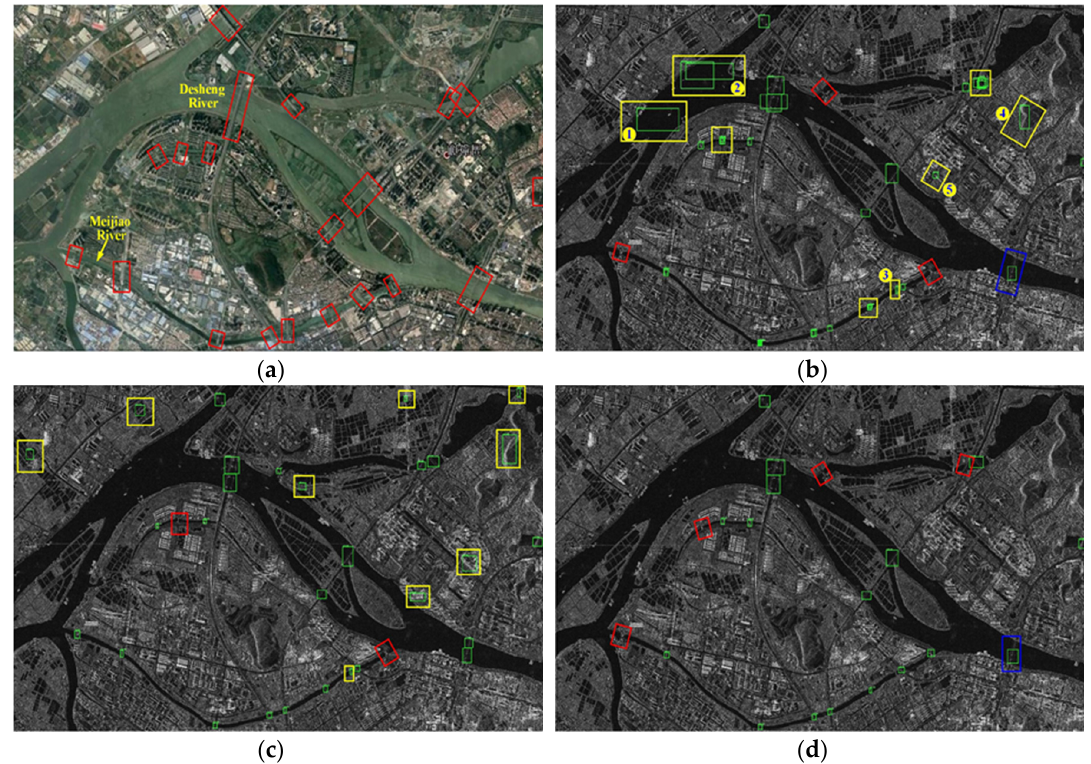
Figure 10. The corresponding optical image and detected results of bridges by di ff erent networks for Scene 1. ( a ) the corresponding optical image of Scene 1. ( b ) the detected result of bridges by Faster R-CNN. ( c ) the detected result of bridges by SSD. ( d ) the detected result of bridges by